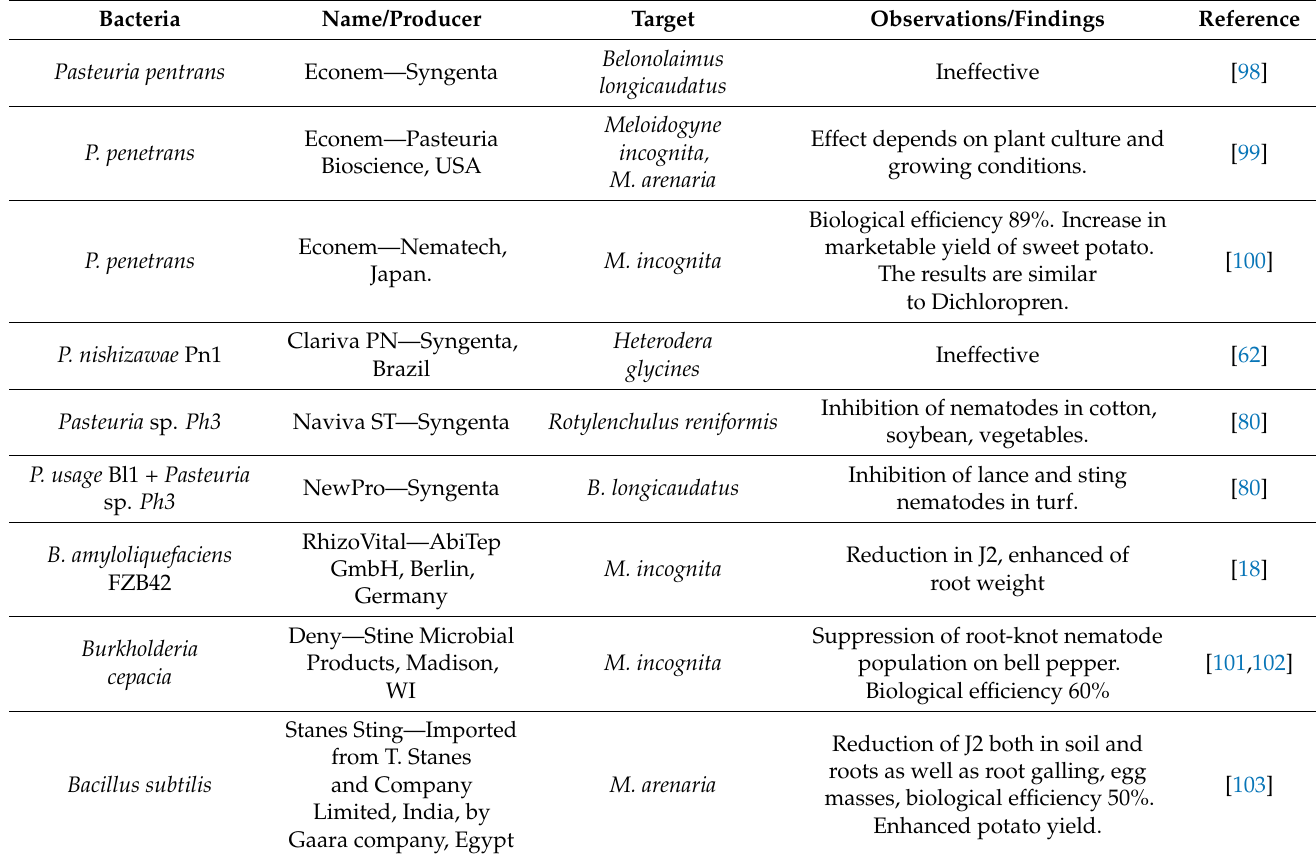
Table 2. List of commercially formulated bacterial biocontrol agents against plant parasitic